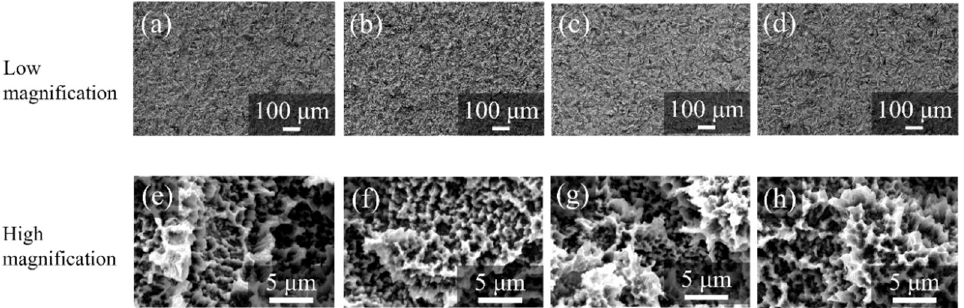
Figure 10. SEM profiles of the surfaces of ZrO 2 /Ti disks after PBS immersion. ( a , e ) 7, ( b , f ) 14, ( c , g ) 30, and ( d , h ) 90 days after immersion. (Magnification of ×100 and ×5000).